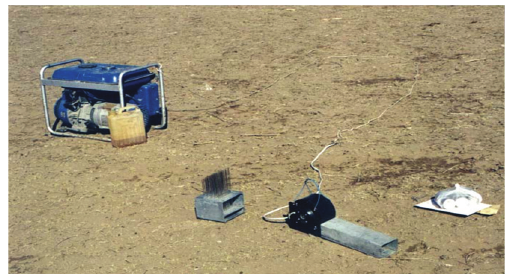
Figure 4: Photograph of the experiment setup in the field.